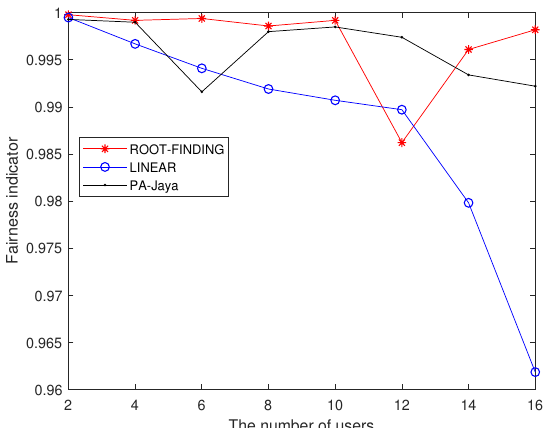
Figure 8. Comparison of different algorithms for the fairness indicator with different user